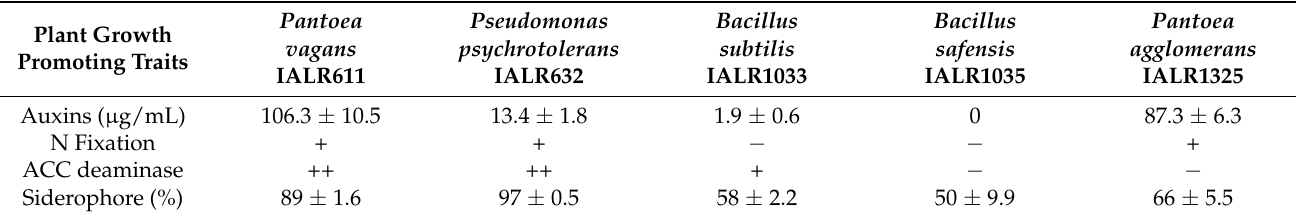
Table 4. Other plant growth promoting traits of phosphate solubilizing bacteria.